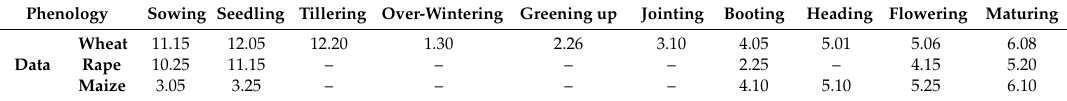
Table 2. Description of the parameters of Sentinel-1